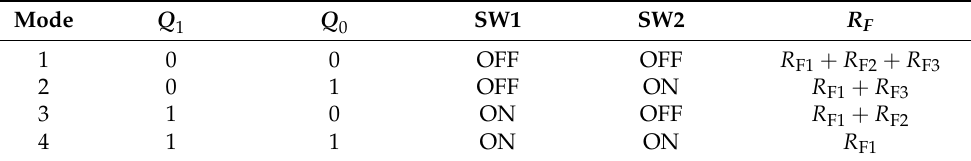
Table 1. Four different modes of the feedback resistance R F